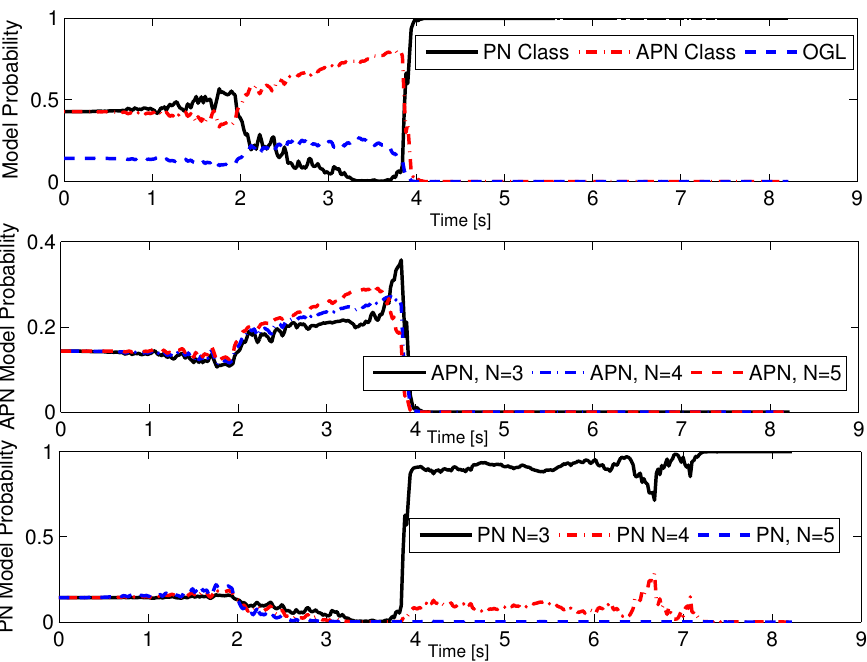
Figure 8. Model probability of the sMME-SRCKF for one Monte Carlo simulation in Case